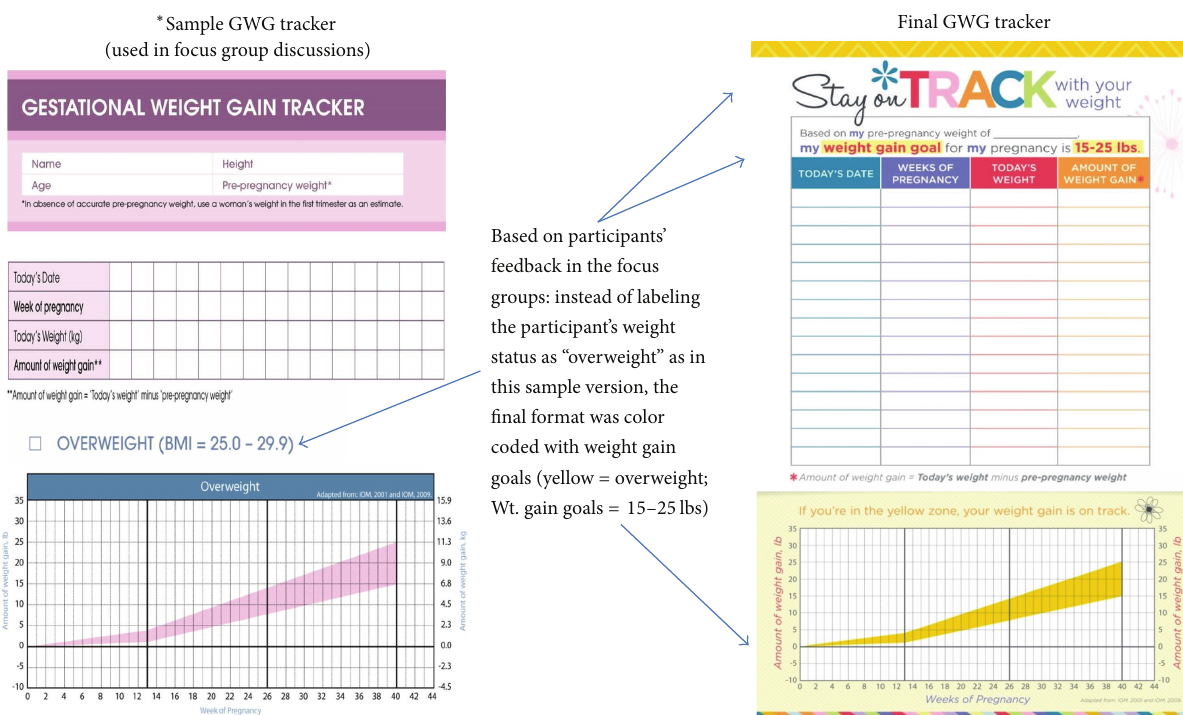
Figure 2: Sample and final pregnancy weight tracker (GWG